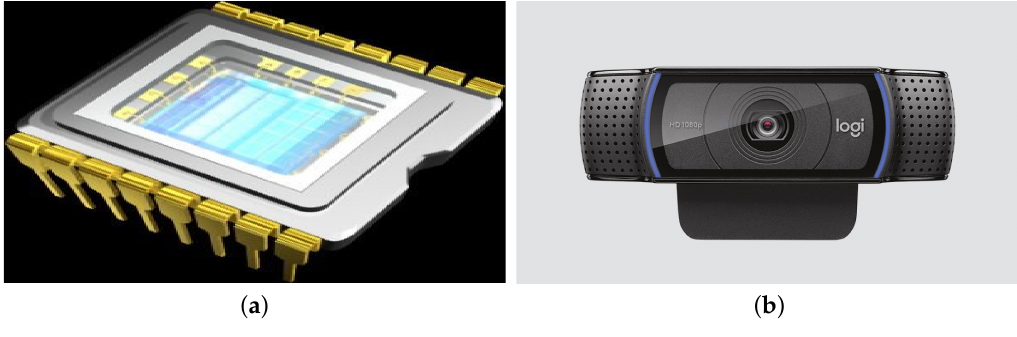
Figure 8. Image Acquisition System: ( a ) Charge-Coupled Device Sensor scheme and ( b ) Logitech